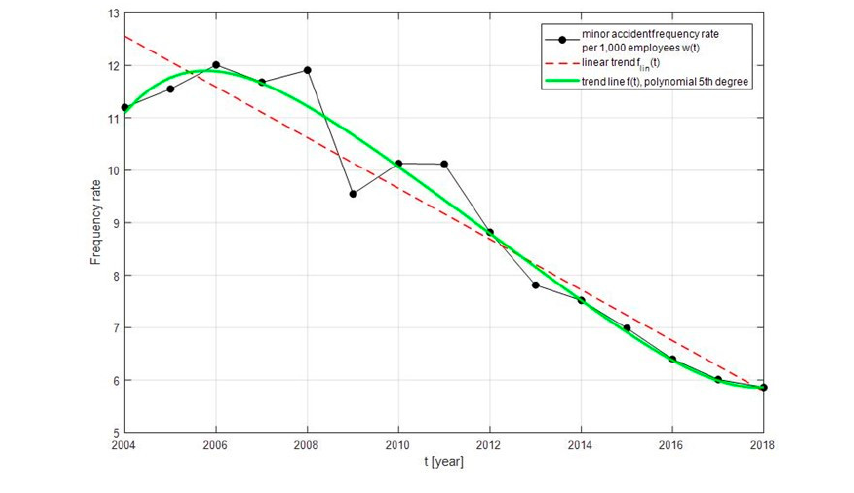
Figure 8. Trends of changes in the frequency of minor accidents in civil engineering over time.